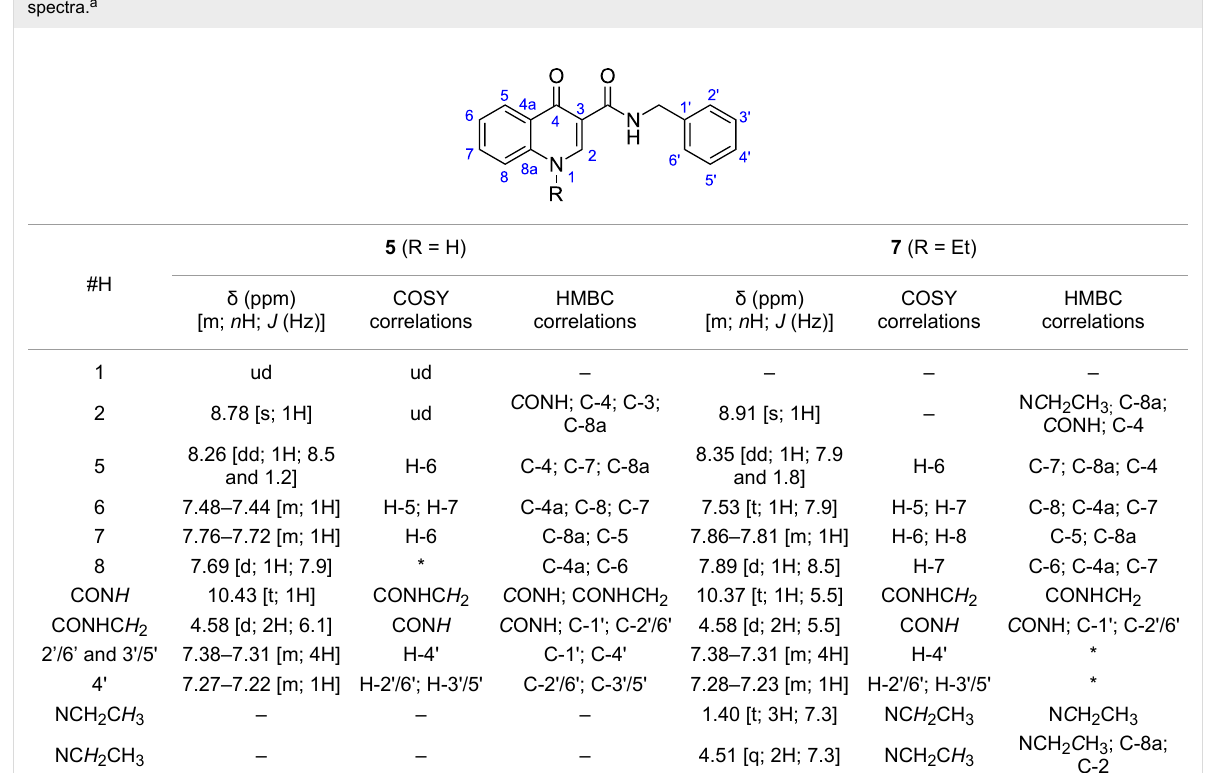
Table 1: 1 H NMR (DMSO- d 6 , 500.00 MHz) data of compounds 5 and 7 , and the correlations observed from the 1 H, 1 H-COSY and 1 H, 13 C-HMBC spectra.